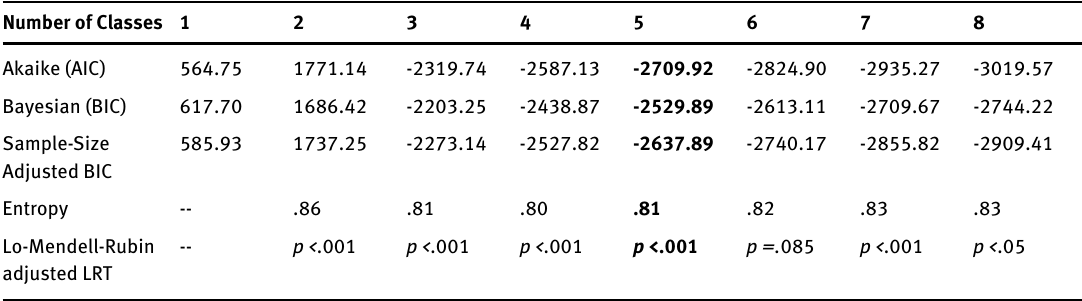
Table 2. Fit indices for latent class analysis models with 1-8 classes in adult US sample Number of Classes 1